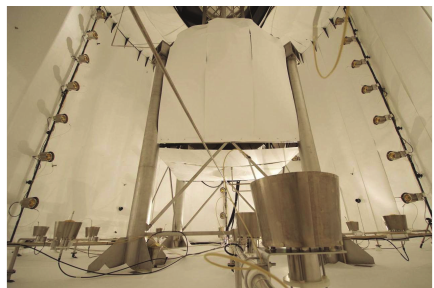
Figure 2: Internal view of the LSV neutron veto from its top port.